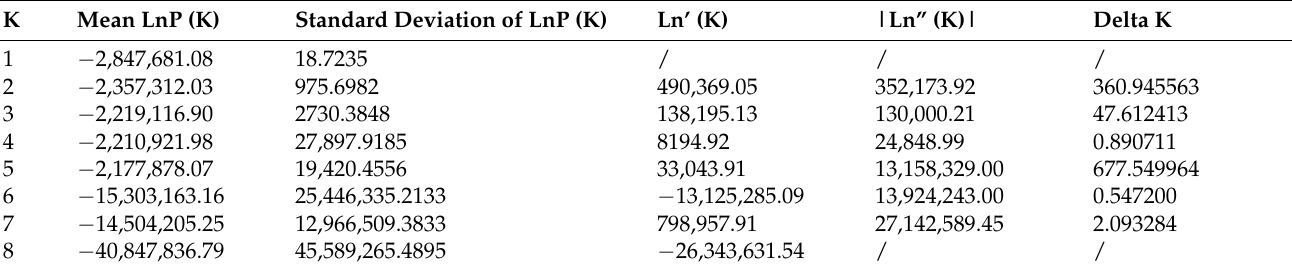
Table A1. The assessment of probability of structure models according to different K values. Ln’ (K)—the mean difference between successive likelihood values of K, Ln” (K)—difference between successive values of L’ (K), Delta K—the mean of the absolute values of L” (K)